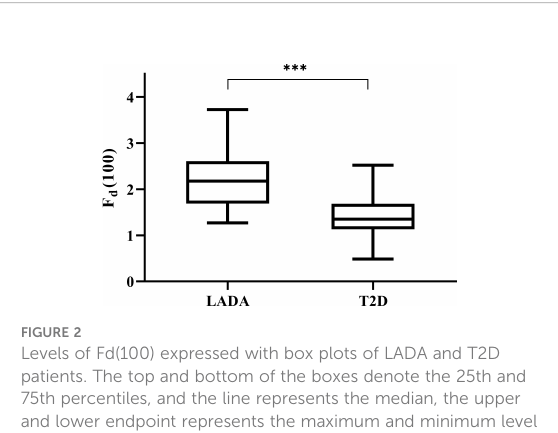
FIGURE 2 Levels of Fd(100) expressed with box plots of LADA and T2D patients. The top and bottom of the boxes denote the 25th and 75th percentiles, and the line represents the median, the upper and lower endpoint represents the maximum and minimum level respectively. LADA, latent autoimmune diabetes in adults; T2D, type 2 diabetes. ***P <